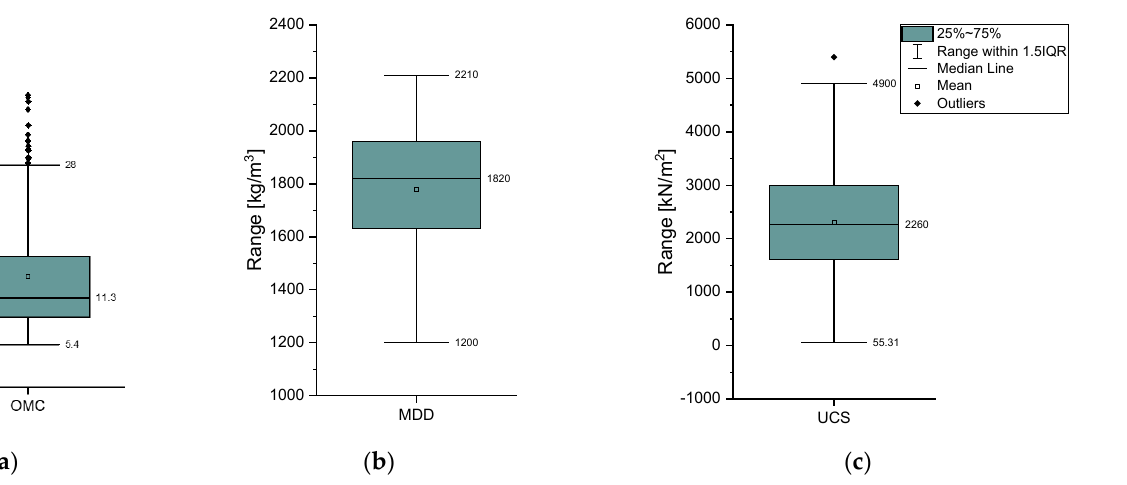
Figure 5. Box plots of ( a ) OMC, ( b ) MDD, and ( c ) UCS.